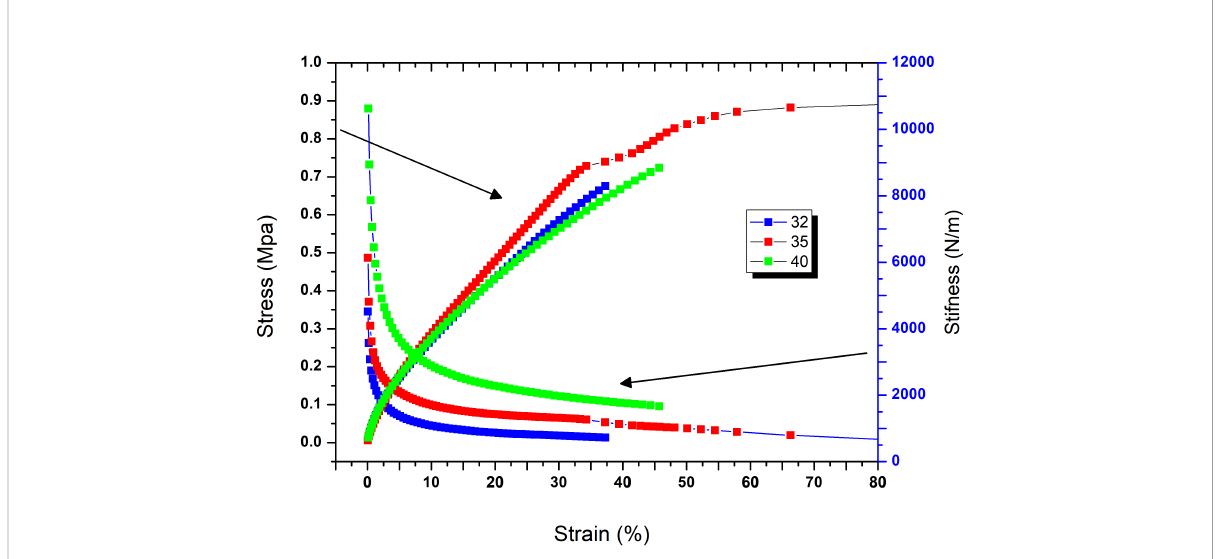
FIGURE 4 Strain vs. stress and stiffness for the 3-week samples at different temperatures (32°C, 35°C, and